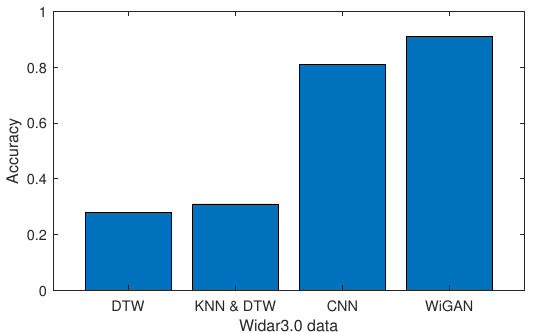
Figure 8. Comparison of the accuracy of cross-user recognition.